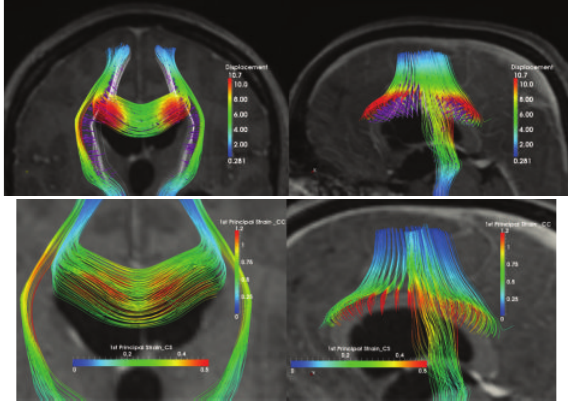
Figure 4: Upperrow: displacement of the CC and CS fiber tracts during hydrocephalus development overplayed with the pre- operative brain image at coronal cross-section (left) and sagittal cross-section (right). The axonal tracts with white color represent the tracts at the healthy stage, the purple arrow shows the displace- ment occurred during hydrocephalus development with the arrow lengthinproportiontothedisplacementmagnitude,andthecolored fiber tracts represent the distorted tracts at postoperative stage with color scale legend indicating magnitude of displacement. Lower row: the 1st principal strain levels at the CS and the CC fiber tracts. Note that the color scale for the CS and CC fiber tracts is different in order to have a better